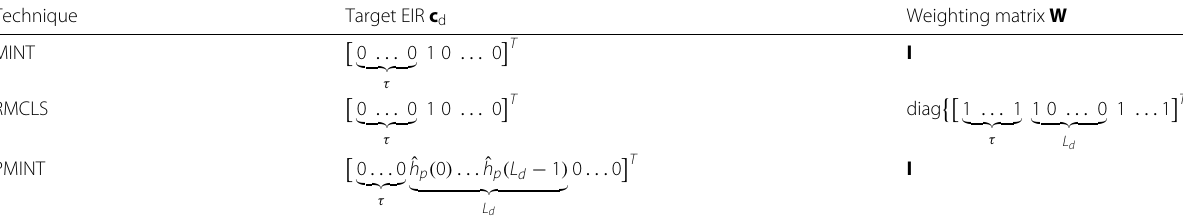
Table 1 Definition of the target EIR c d and weighting matrix W for MINT, RMCLS, and PMINT